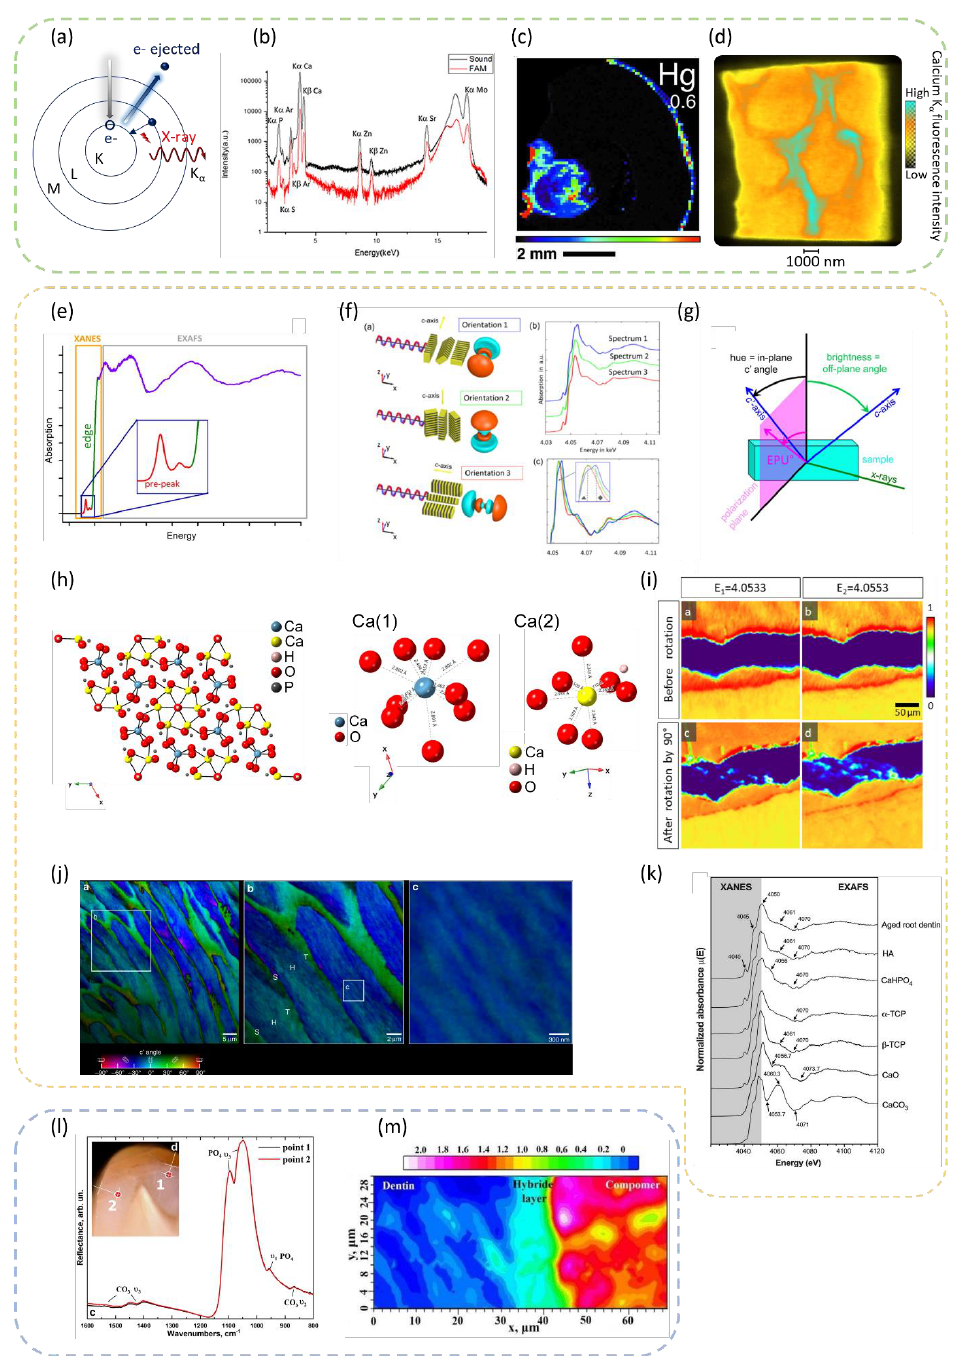
Figure 9. Details of the spectroscopy techniques used for dental research applications. ( a ) Principle of XRF analysis based on the emission of the characteristic X-ray (e- refers to electrons, adapted from [651], license https://creativecommons.org/licenses/by/4.0/ accessed on 30 March 2023). ( b ) XRF spectra of sound enamel and enamel from a patient with FAM20A mutations, (adapted